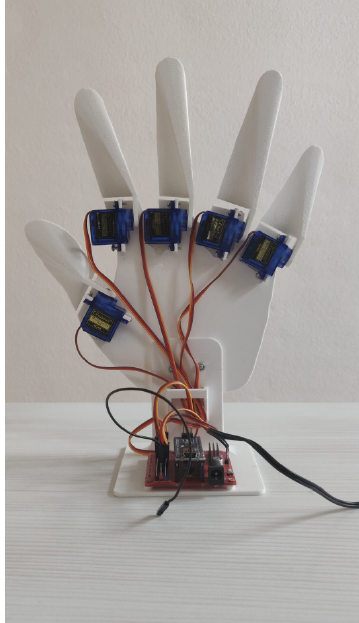
Figure 10. Arduino based rehabilitation